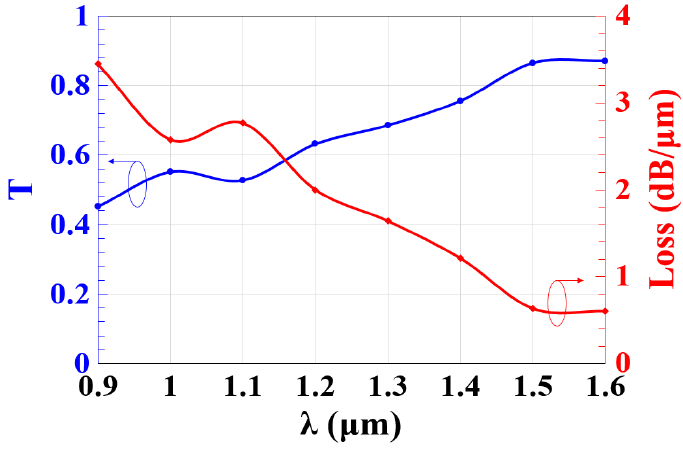
Figure 2. Spectral transmission (T) and loss versus operating wavelength ( λ ) utilizing 2 × 2 silicon waveguide.